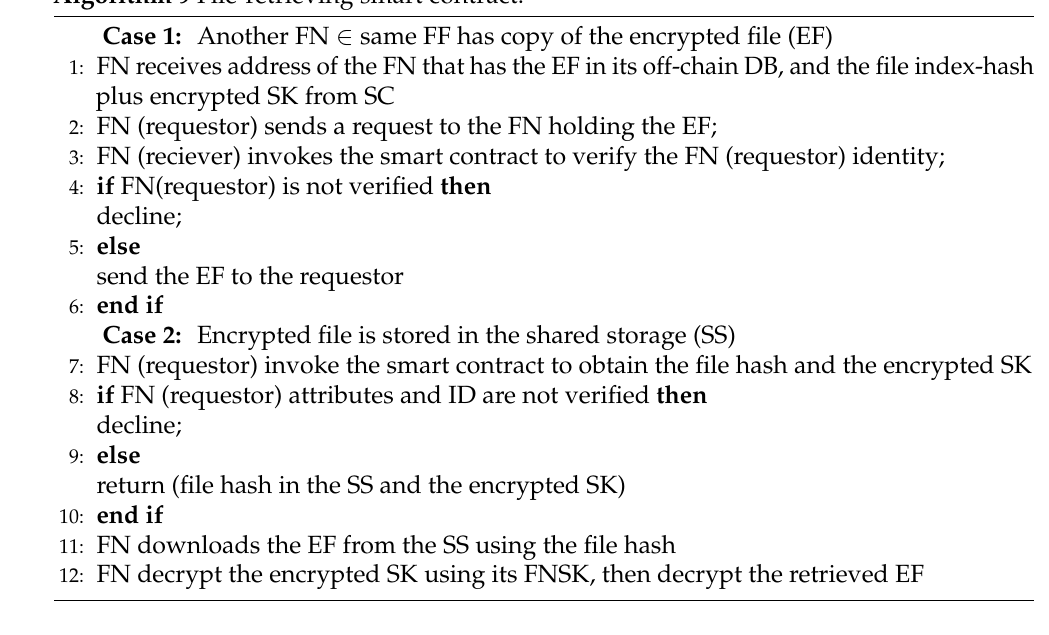
Algorithm 9 File-retrieving smart